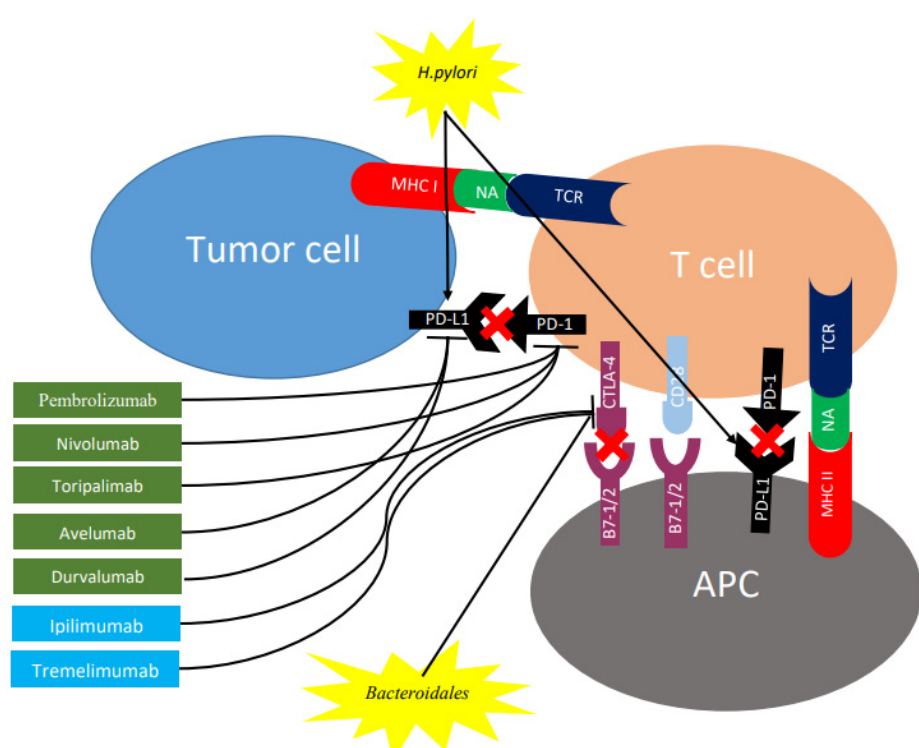
Figure 2. Role of checkpoint inhibitors and gut microbiome on expression of CTLA-4 and PD-1 in regulating different stages of T cell response. T cell activation requires two complementary signals: The interaction between the TCR and peptide-MHC complex must be associated with a second co-stimulatory signal mediated by CD28. Conversely, the binding of CTLA4 to B7-1/2 provides a control signal that suppresses ongoing T cell activation. PD-1 is upregulated on T cells following persistent antigen exposure. When PD1 binds to its ligand, PD-L1 or PD-L2, expressed by tumor cells, the T cell receives an inhibitory signal. Antibodies against CTLA-4 (shown in blue rectangles) or PD-1/PD-L1 (shown in green rectangles) can activate T cells. H. pylori increases gastric epithelial expression of PD-L1 while bacteroides block CTLA-4 expression. CTLA-4, cytotoxic T lymphocyte antigen 4; PD-1, programmed cell death protein 1; TCR, T cell receptor; MHC, major histocompatibility complex; PD-L1, programmed death ligand 1; APC, antigen-presenting cell; NA,